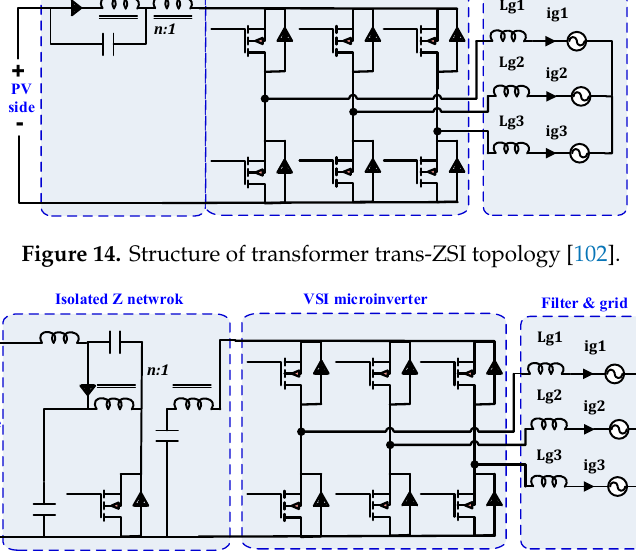
Figure 15. Structure of voltage fed isolated ZSI topology [103].